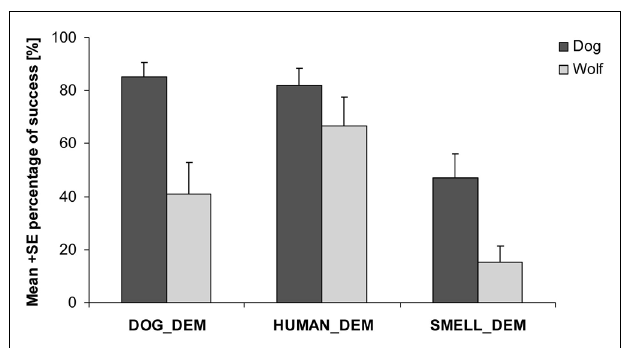
FIGURE 2 | Proportion of success finding the chick for wolves and dogs in the dog demonstrator (DOG_DEM), human demonstrator (HUMAN_DEM) and smell control (SMELL_CON)